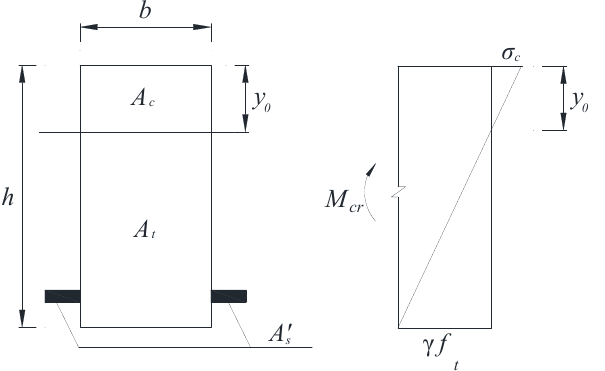
Figure 6. Conversion section and its stress distribution.